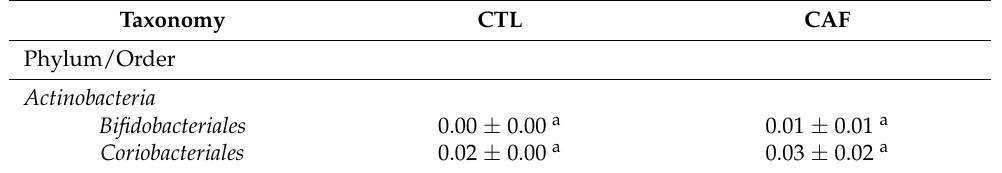
Table 3. Relative abundance of gut bacterial taxa at order, family and genus levels of male Wistar rats. Taxonomy